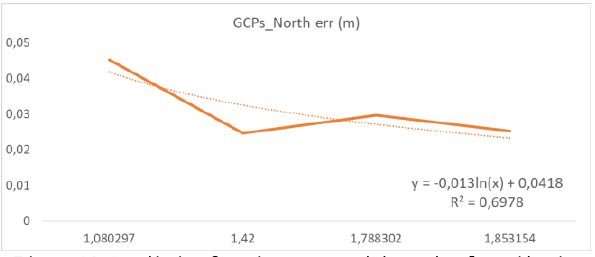
Figure 10. Predictive function extracted through a logarithmic interpolation between depend (synthetic index) and independent Figure 14. Predictive function extracted through a polynomial variables (northern error component). R 2 : coefficient of interpolation between depend (synthetic index) and independent determination. variables (eastern error component). R 2 : coefficient of determination.